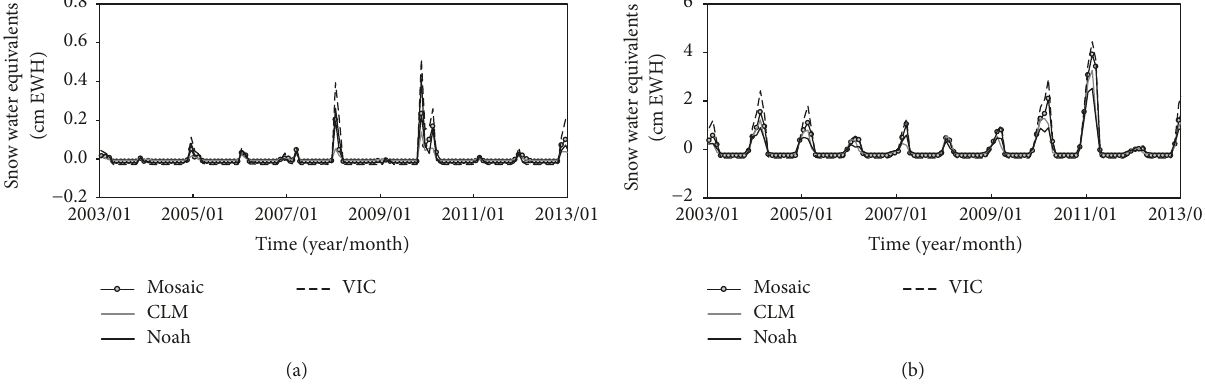
Figure 12: Monthly temporal variations of snow water equivalents of four LSMs in GLDAS in (a) the Huang-Huai-Hai Plain and (b) the Song-Liao